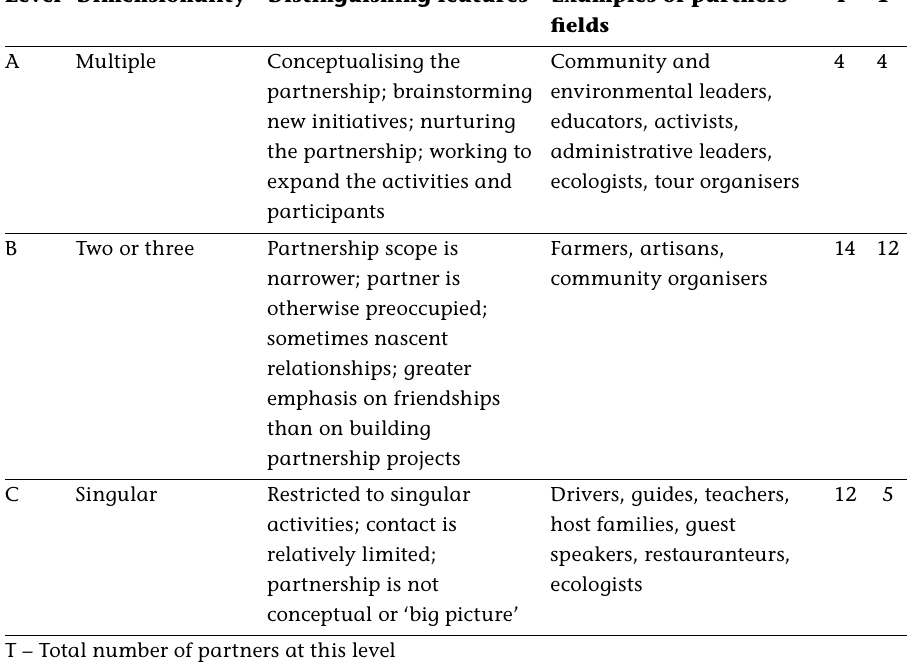
Table 1: Three levels of partnership